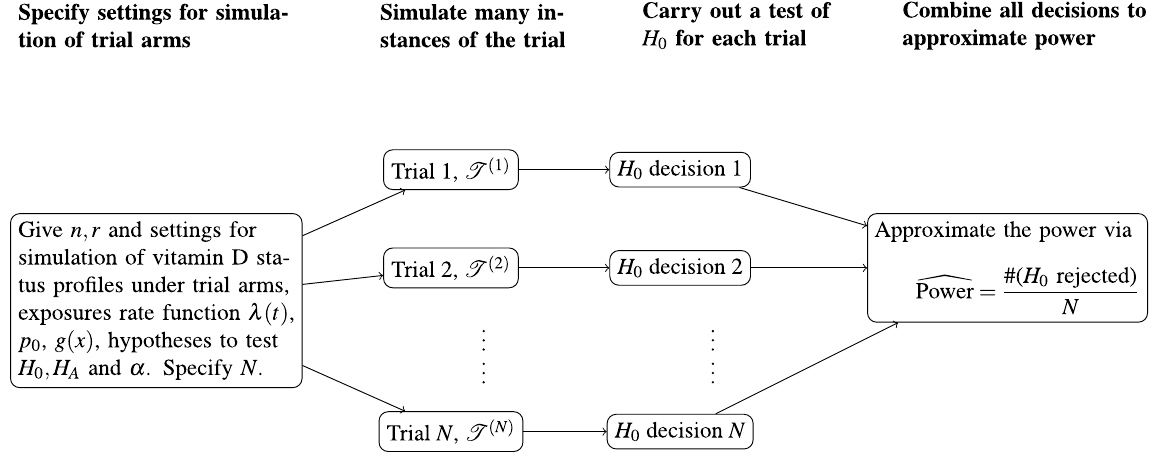
Figure 3. Simulation process for estimating the power of a